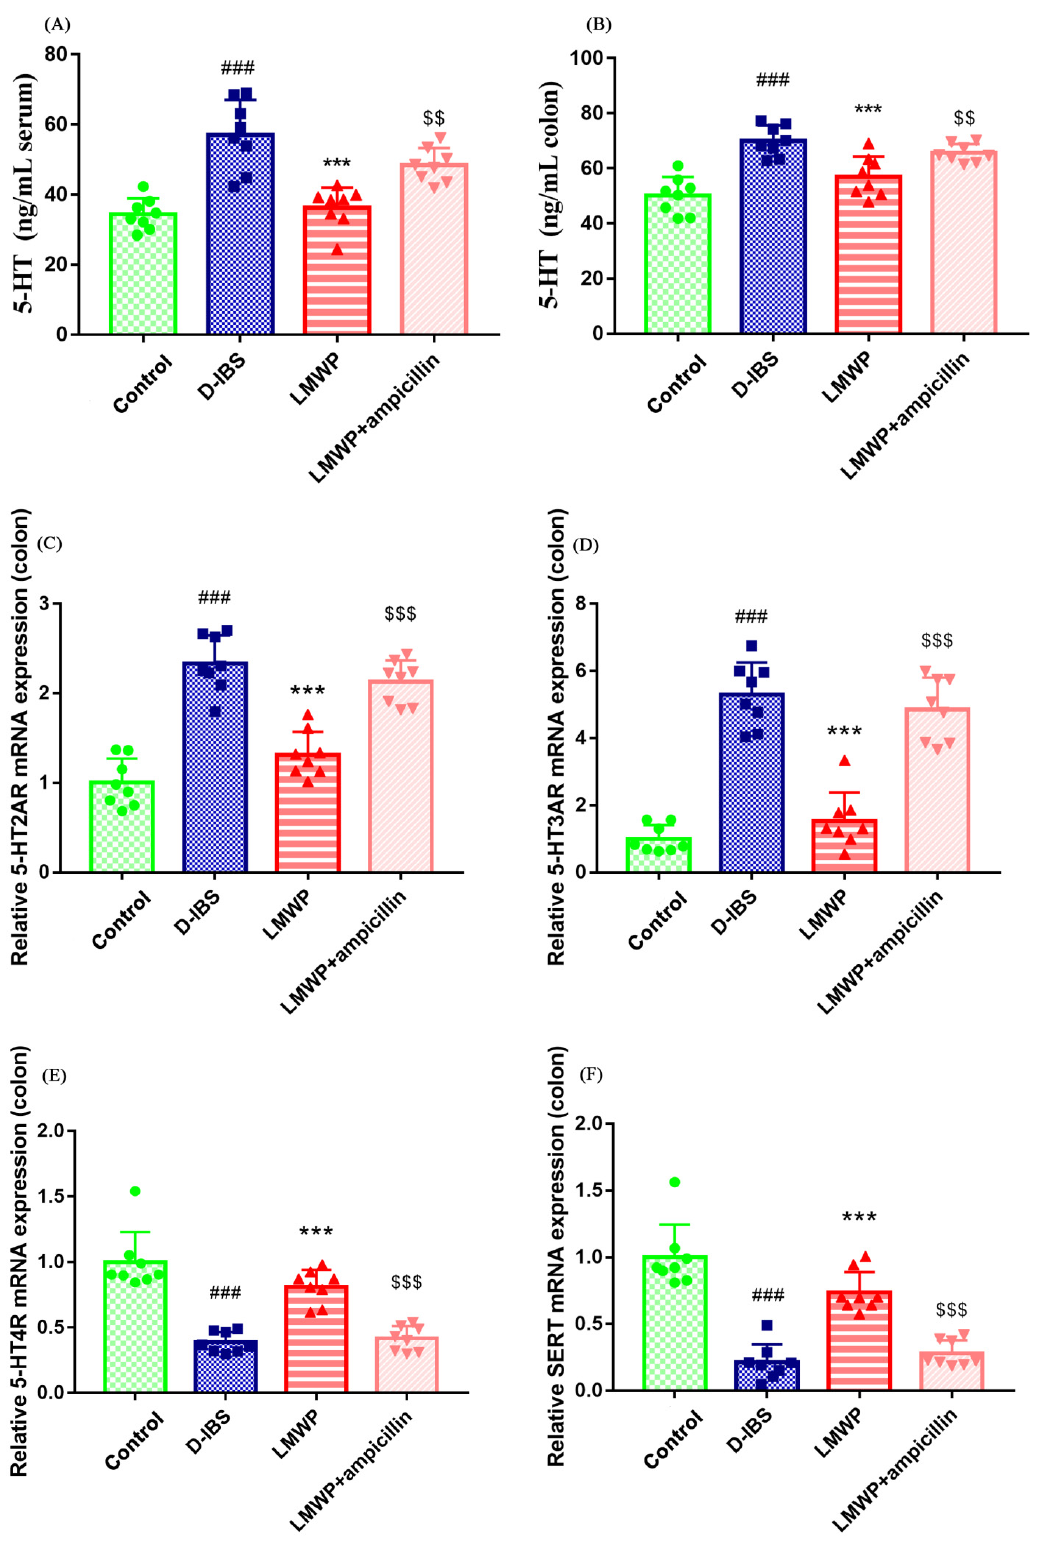
Figure 4. LMWP (S3-3) from the larvae of Musca domestica affect 5-HT, 5-HT2AR, 5-HT3AR, 5-HT4R and SERT in D-IBS mice. ( A , B ) 5-HT levels in serum and colon. ( C – F ) The relative expression of 5-HT2AR, 5-HT3AR, 5-HT4R and SERT mRNA in the colon. Values are presented as means ± SD ( n = 8). ### p < 0.001 compared with Control, *** p < 0.001 compared with D-IBS, $$ p < 0.01 and $$$ p < 0.001 compared with LMWP (S3-3) from the larvae of Musca domestica